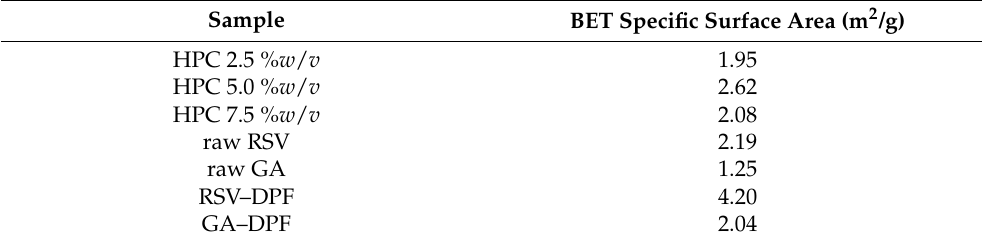
Table 5. Specific surface area (m 2 /g) of both raw phenolics and respective RSV and